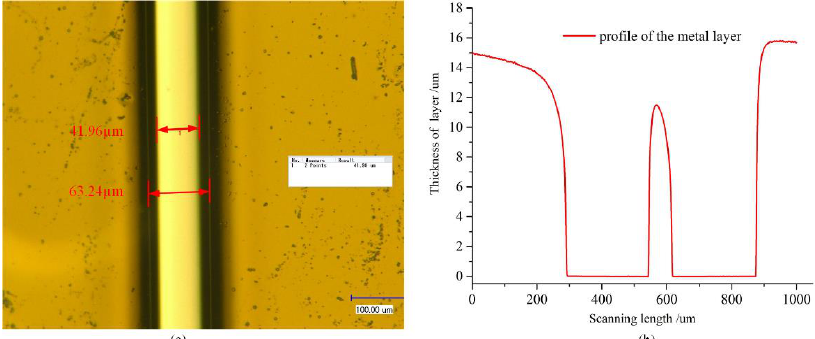
Figure 11. ( a ) The picture of Cr layer under a light microscope; ( b ) the profile of Cr layer with the step profiler.